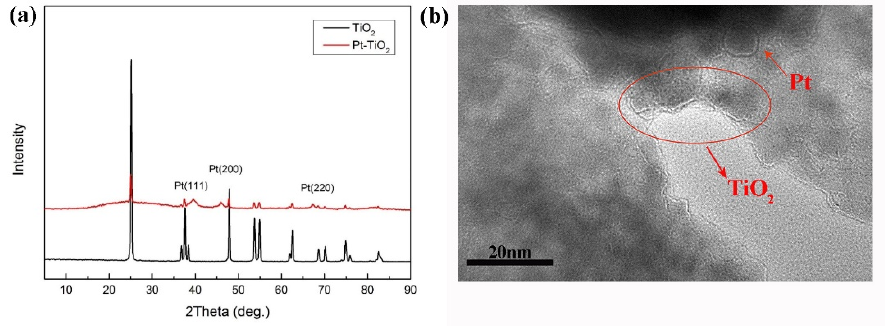
Figure 3. X-ray diffraction pattern ( a ) and TEM image ( b ) of Pt-TiO 2 nanoparticles.